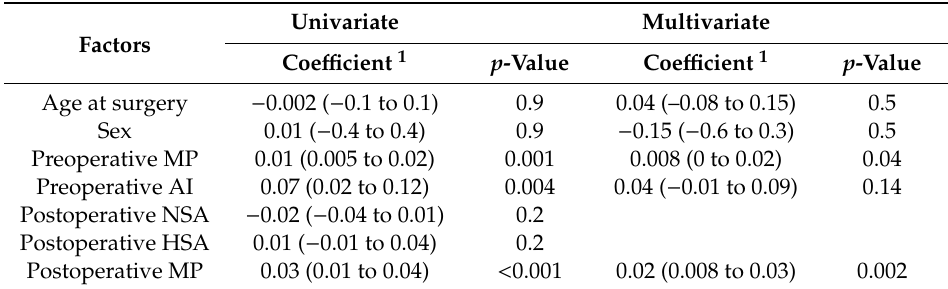
Table 3. Factors a ff ecting the final Melbourne Cerebral Palsy Hip Classification Scale (MCPHCS) grade using linear mixed